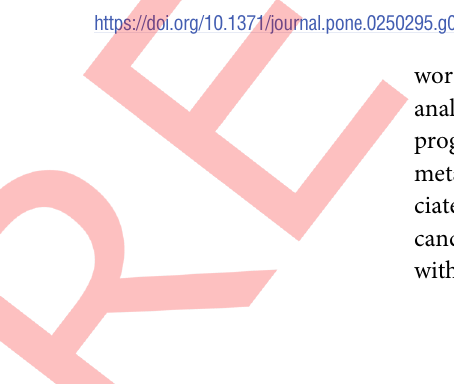
PLOS ONE | https://doi.org/10.1371/journal.pone.0250295 April 26,